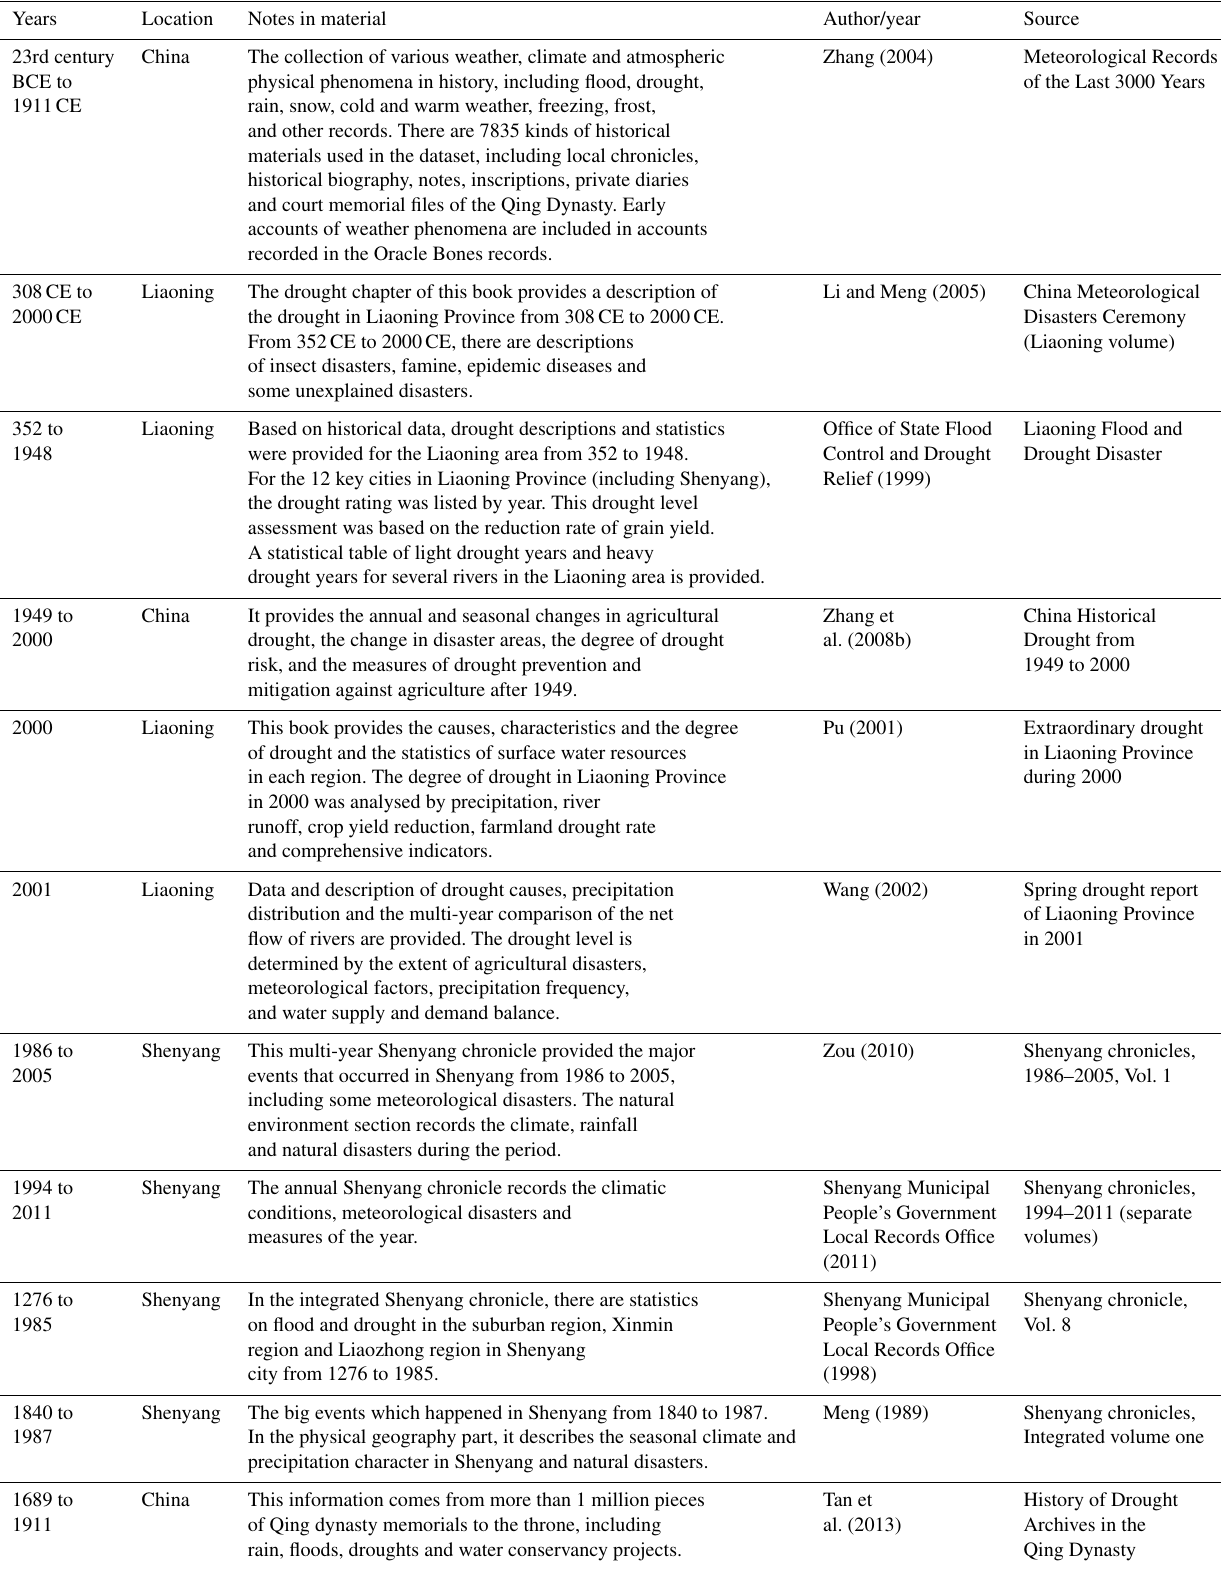
Table 1. Historical source materials used in the drought reconstruction for